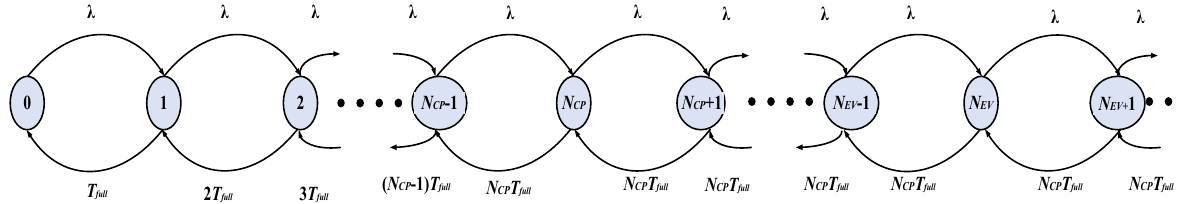
Figure 1. The schematic diagram for EVs charging process with a dynamic queue model.